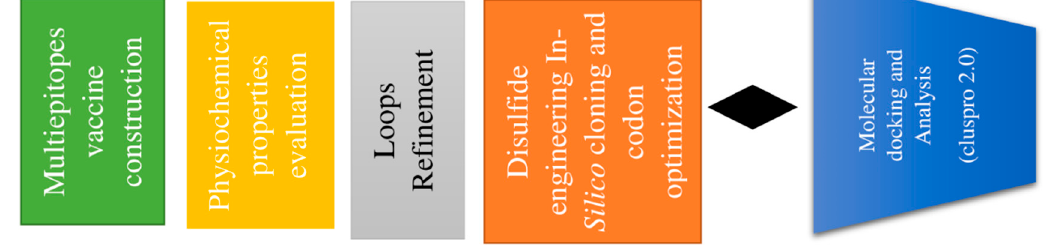
Figure 1. Schematic diagram of methods applied for designing a multi-epitope-based vaccine against E. xiangfangensis. The methods can be split into the retrieval of the complete proteome, prescreening phase, vaccine target prioritization phase, epitope prioritization and selection, multi-epitope vaccine designing and processing, molecular docking, molecular dynamics simulation and binding free energy calculations.